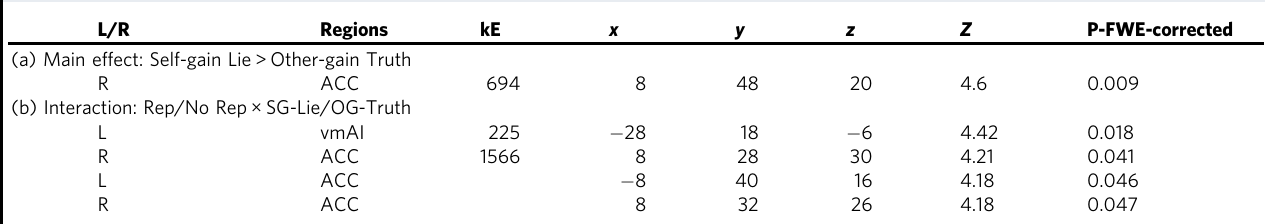
Only clusters and their local maxima that survived family-wise error (FWE) correction ( p <0.05) are presented. L / R left/right, kE number of voxels, p-FWE family-wise error corrected p -value, ACC anterior cingulate cortex, vmAI ventromedial anterior